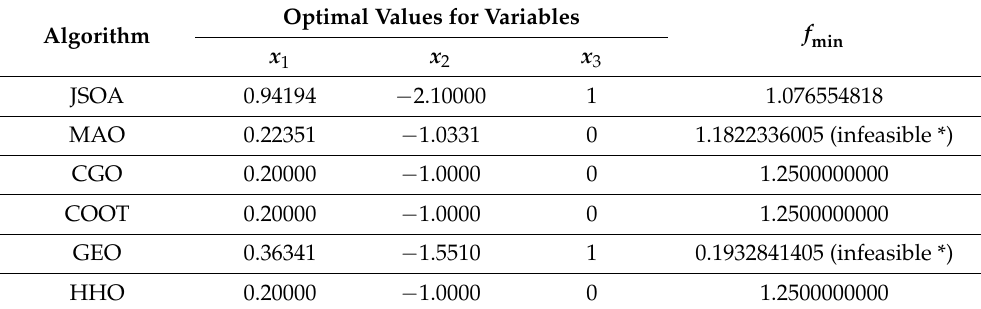
Table 6. Process Flow Sheeting problem—Comparison Results.